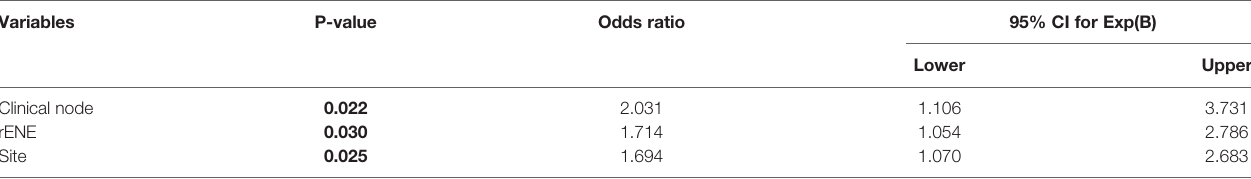
TABLE 6 | Multivariate analysis to determine factors predicting clinical response.